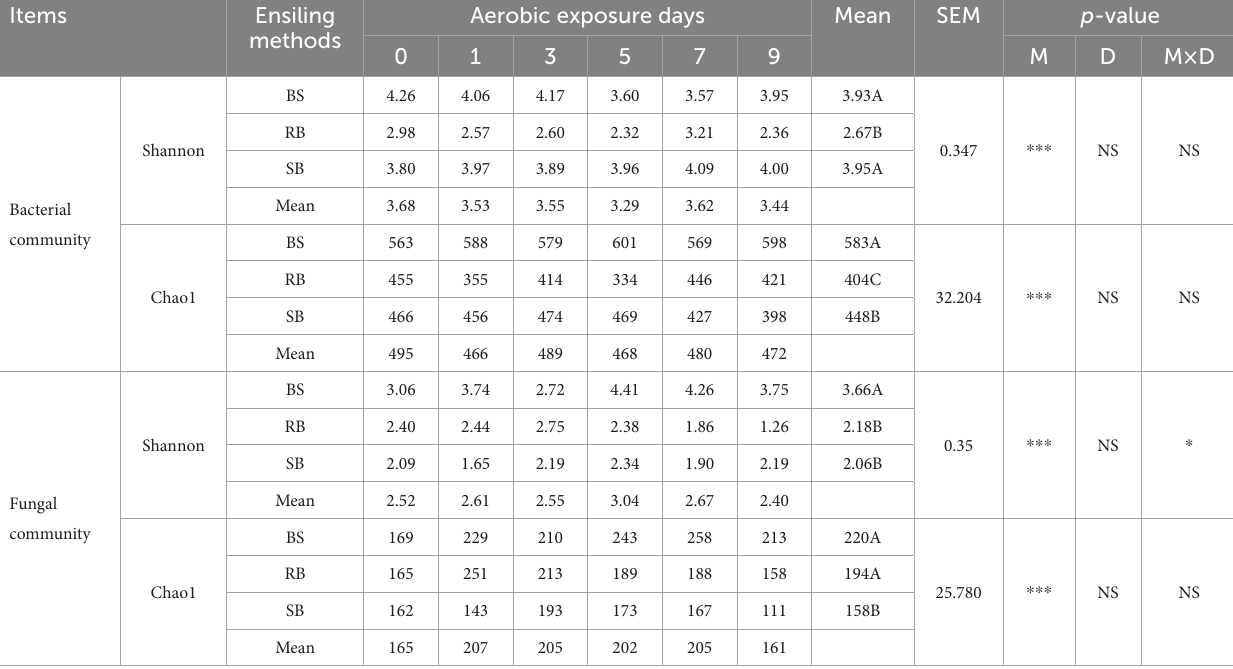
TABLE 4 Alpha diversity of microbial community during aerobic exposure. Items